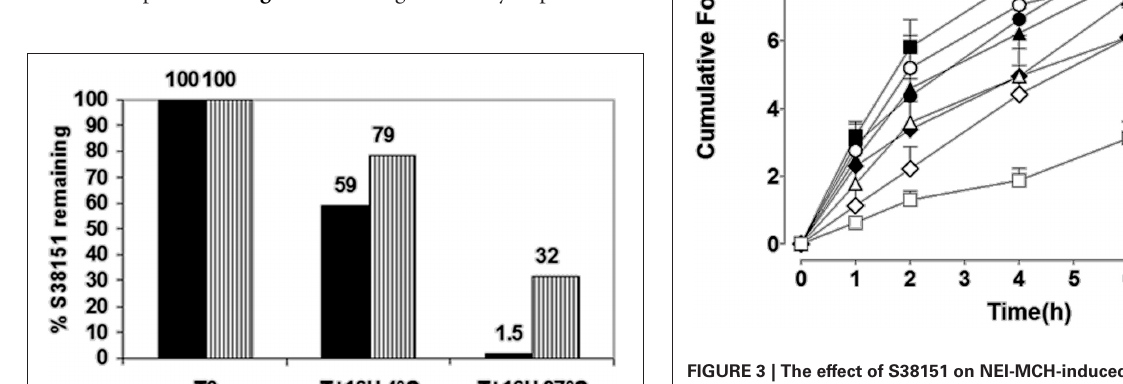
FIGURE 3 | The effect of S38151 on NEI-MCH-induced food intake in Wistar rats after acute central administration. Satiated rats were injected (i.c.v.) at the beginning of the light phase with 5 μ g NEI-MCH, 5 μ g NEI-MCH + differing doses of S38151 (0.5–50nmol/kg), or an equivalent volume of artificial cereblospinal fluid vehicle (5 μ L). Cumulative food intake was measured at 1, 2, 4, 6, and 24h post-injection. Results are expressed as mean ± SEM ( n = 10–11 rats per group). Repeated measures Two-Way ANOVA (treatment × time) was followed by post hoc Student-Neuman-Keulsanalysis to compare all groups of